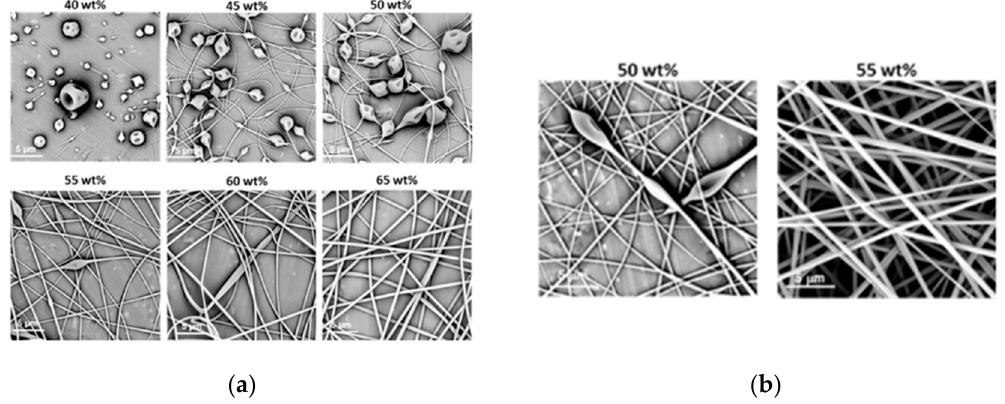
Figure 2. Morphology of structures after electrospinning of ( a ) PiPrOx 21k and ( b ) PiPrOx 42k at different concentrations (wt %: weight percent) in water (flow rate of 1 mL/h).